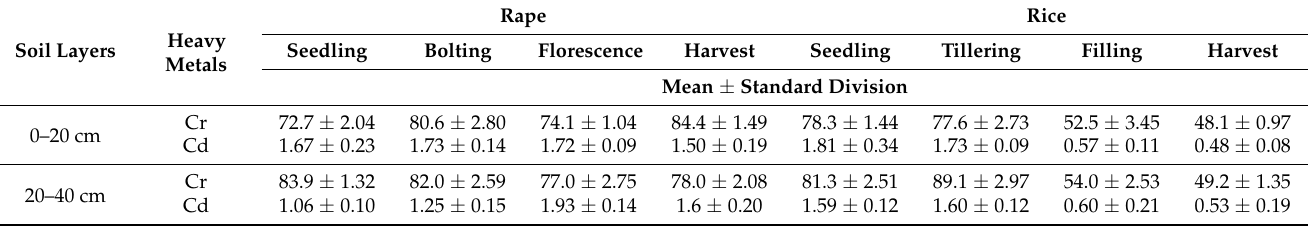
Table 2. Characteristics of Cr and Cd in soil during rice rape rotation